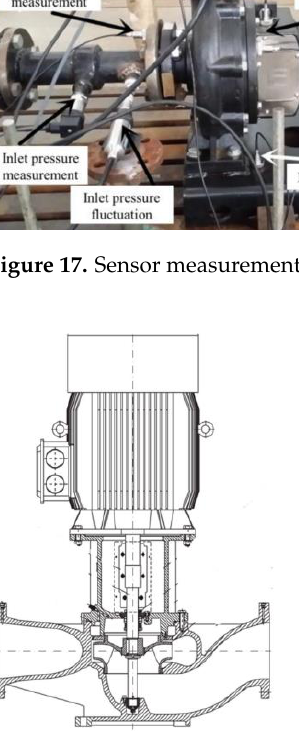
Figure 17. Sensor measurement point layout [78].